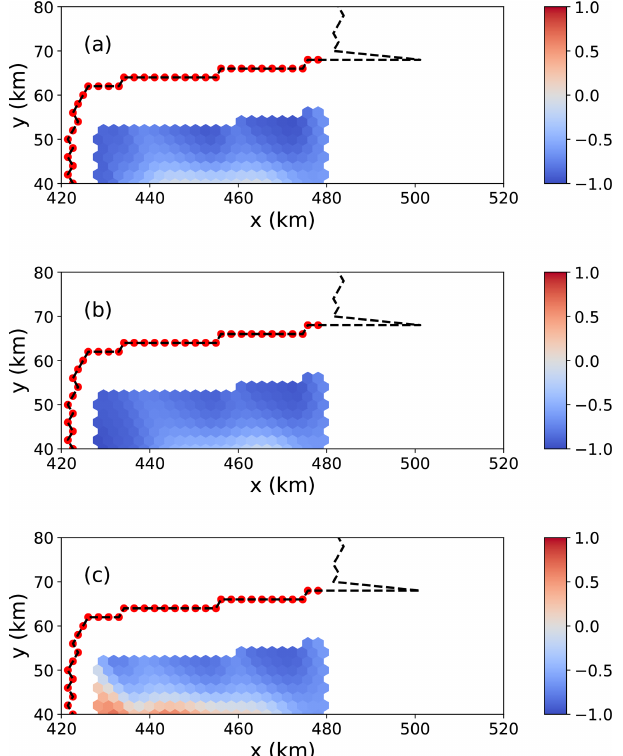
Figure 8. Spatial distribution of the correlation coefficient ϒ gl from Eq. (13) over the MISMIP + domain for buttressing number changes calculated parallel to (a) n gl , (b) n p1 , and (c) n p2 (colors). ϒ gl is a measure of the correlation between changes in buttressing num- ber and ice speed along the grounding line. The dashed black line represents the grounding line, and the red dots indicate the area of the grounding line for which values of ϒ gl are calculated for each perturbation on the ice shelf, as shown in Fig. 4a.